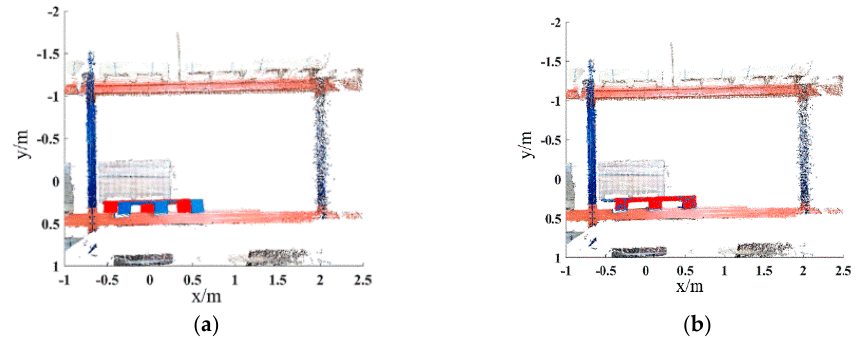
Figure 21. The result of point registration in the shelf scene. ( a ) Initial pose relationship. ( b ) Fine registration. The red points represents the template point cloud. Table 5. RMSE and elapsed time comparison of different feature descriptors in the shelf